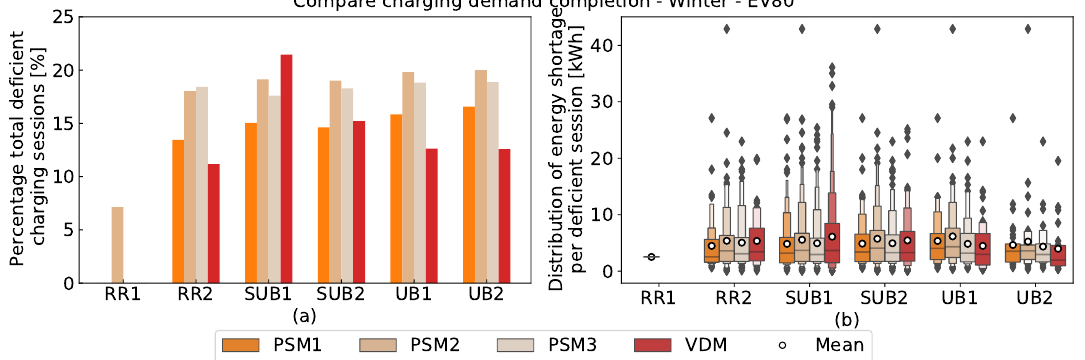
Figure 13. Comparison of charging demand satisfaction of EV 80% scenario in winter. ( a ) Percentage of total deficient charging sessions; ( b ) Distribution of unfinished charging energy per